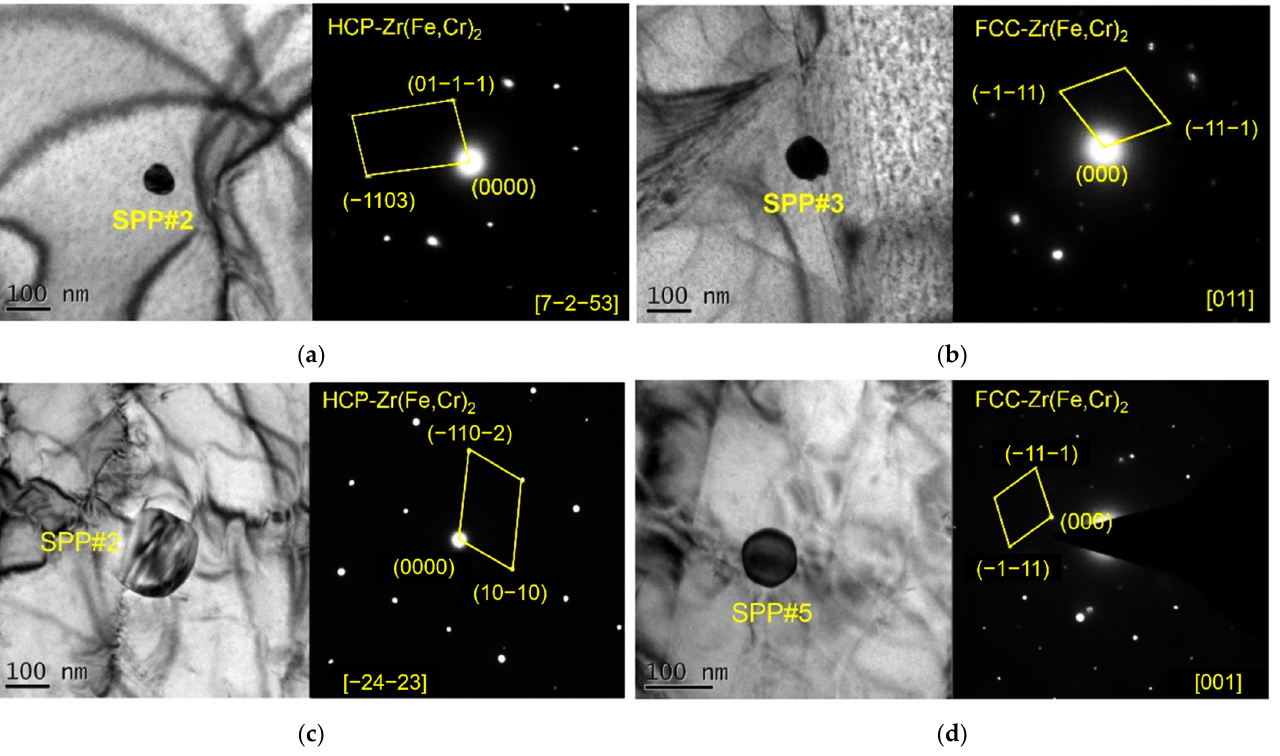
Figure 6. TEM and SAED images: ( a ) Zr(Fe,Cr) 2 with HCP structure in original plates; ( b ) Zr(Fe,Cr) 2 with FCC structure in original plates; ( c ) Zr(Fe,Cr) 2 with HCP structure in reprocessed plates; and ( d ) Zr(Fe,Cr) 2 with FCC structure in reprocessed plates.